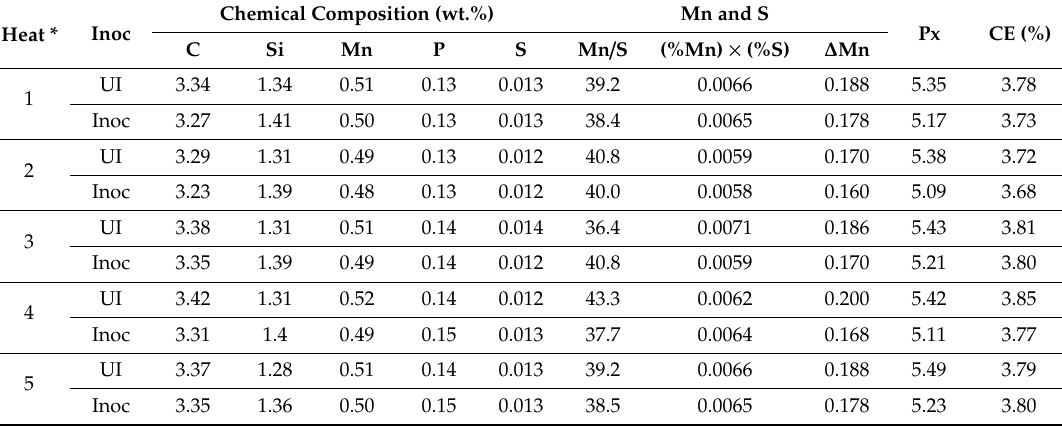
Table 3. Base chemical composition, pearlitic factor (Px) and carbon equivalent